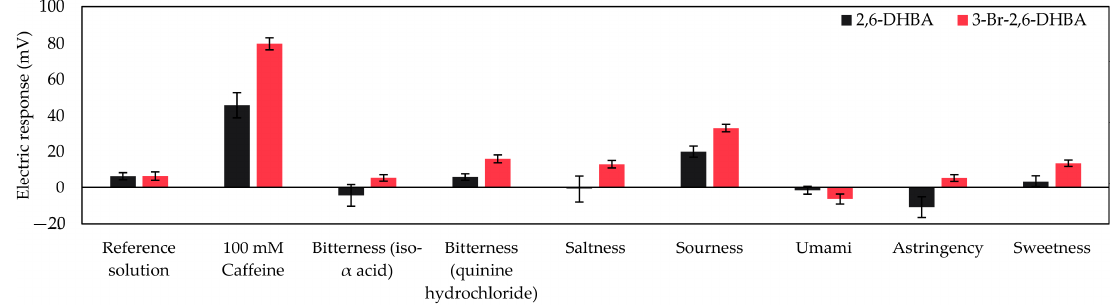
Figure 11. Response to five basic tastes and astringency in sample solutions measured using taste sensors with lipid/polymer membrane modified with 0.03 wt% 2,6-DHBA and 3-Br-2,6-DHBA. The error bar indicates the SD of data, n = 8 (electrode) × 1 (rotation) = 8 values.